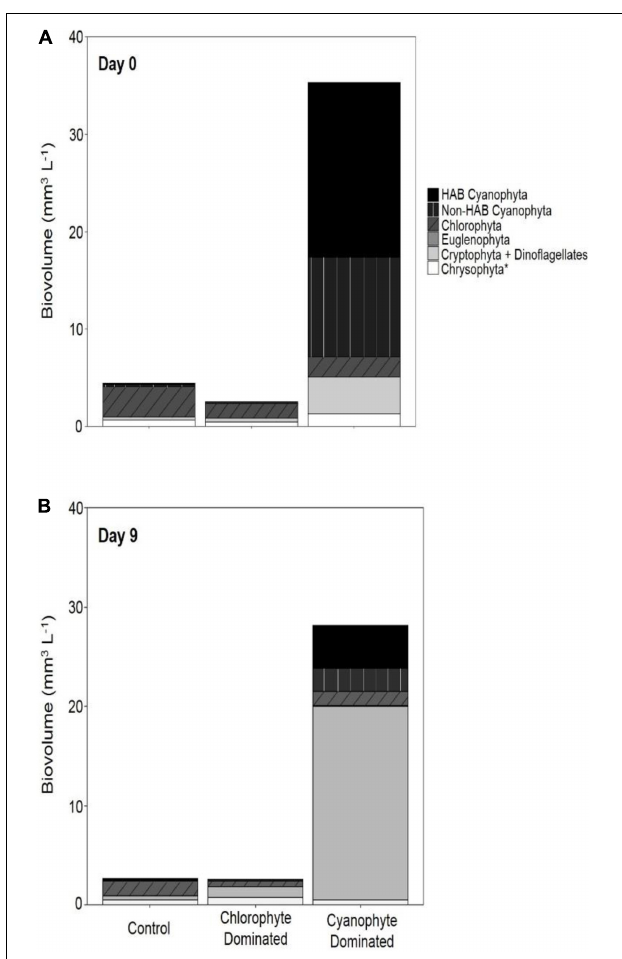
FIGURE 3 | Phytoplankton biovolume categorized by functional group. Biovolume for day 0 (A) and day 9 (B) for control tanks, tanks dominated by chlorophytes at the beginning of the experiment, and tanks dominated by cyanophytes at the beginning of the experiment. The chrysophyta* group includes chrysophyta, bacillariophyta, haptophyta, and ochrophyta.